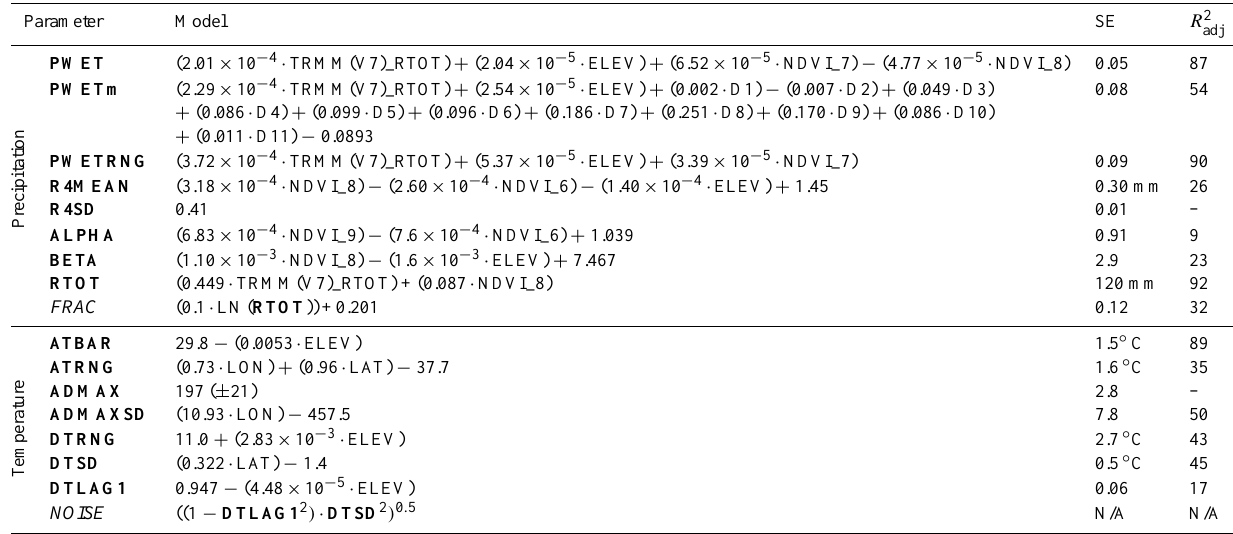
values are cited the sample mean has been applied. adj